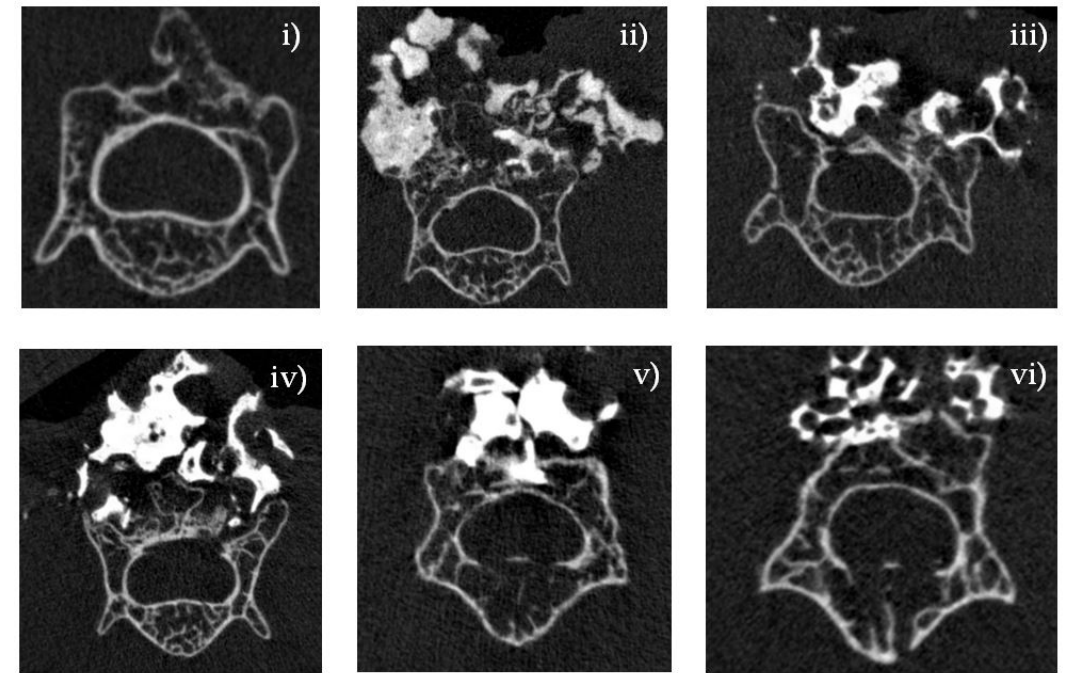
Figure 7. Micro-CT analysis of bone regeneration in a spinal fusion model. Three-dimensional reconstructed images and cross-sectional images of micro-CT at 6 weeks. Bone histomorphometry of 3D bone formation architecture. MagOss group showed better graft incorporation into the recipient lamina. ( i ) Decortication, ( ii ) MagOss (100% WH), ( iii ) A (100% β -TCP), ( iv ) B (100% HAp), ( v ) C (30% HAp + 70% β -TCP), ( vi ) D (60% HAp + 40% β -TCP).